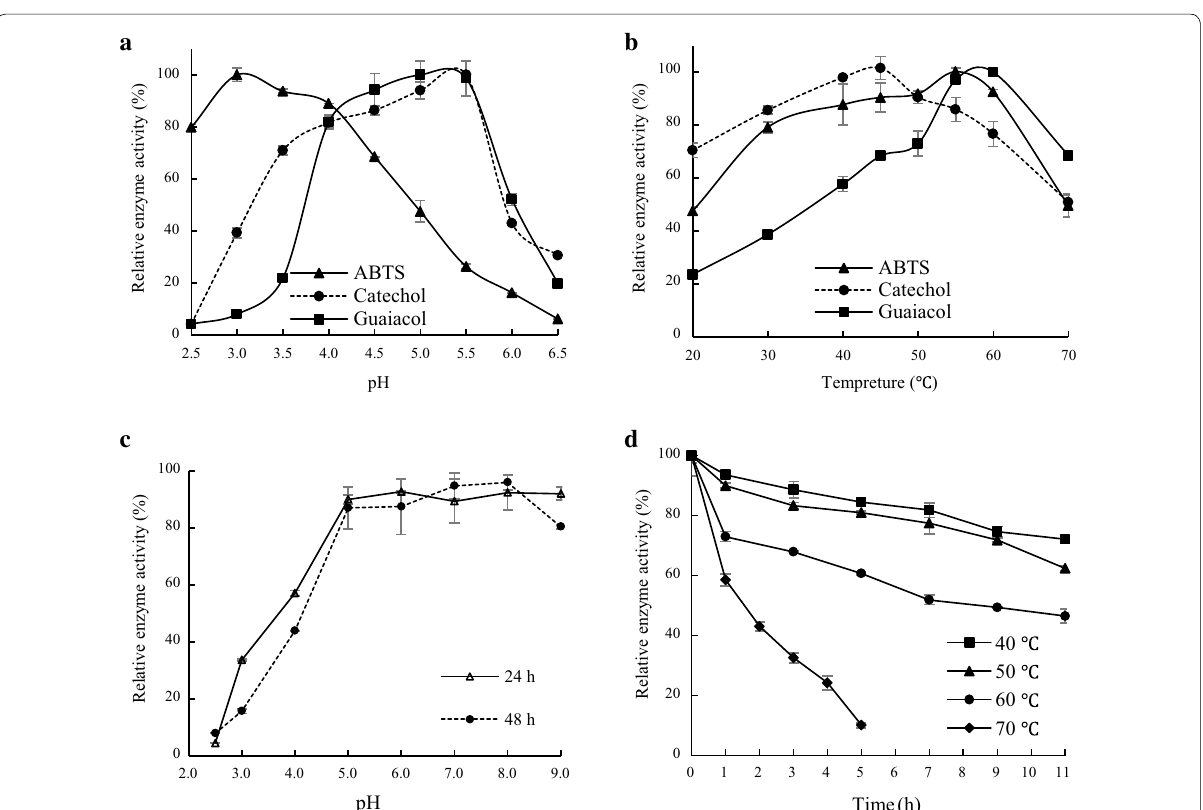
Fig. 4 Effect of pH and temperature on Lac2 activity and stability. a , b Effect of pH and temperature on activity of Lac2. c , d Effect of pH and temperature on stability of